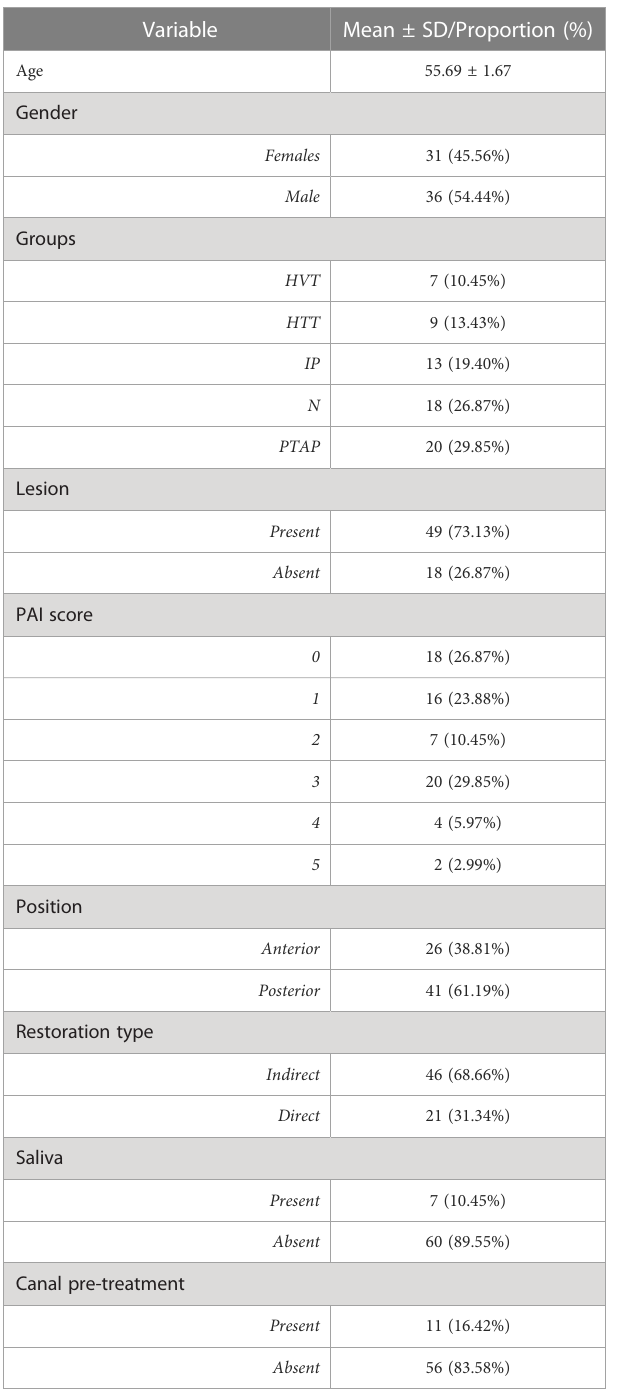
TABLE 1 Descriptive statistics of patients ’